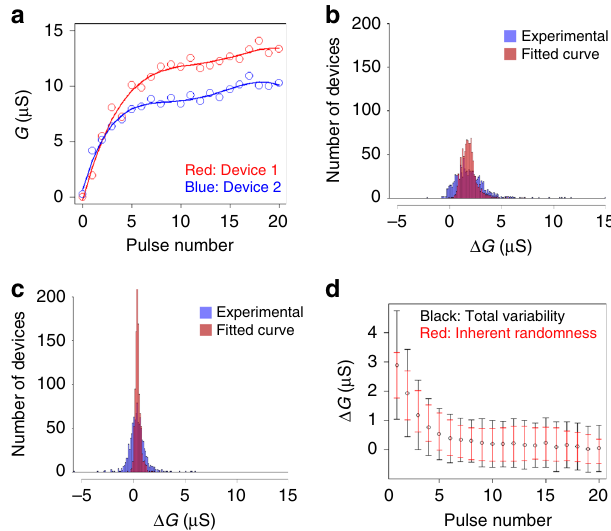
Fig. 5 Separation of device-to-device variability and inherent randomness for PCM. a Device G as a function of pulse number for two representative PCM devices (devices 1 and 2), fabricated with the identical process. The predicted noise-free signals from the GPR fi tting are shown in red and blue solid lines. The difference of two fi tted lines corresponds to device-to- device variability, whereas the fl uctuations of the experimental data around the fi tted lines are attributed to inherent randomness from individual devices. Histograms of Δ G values extracted from experimental data (blue) and fi tted curves (red) ( b ) after the second pulse and ( c ) after the sixth pulse. d The mean and standard deviation of Δ G obtained from the experimental data (shown in black circles and error bars) were compared with the root mean square of inherent randomness ( r ) obtained from the GPR-based methodology (shown in red error bars) as a function of pulse number. The inherent randomness accounts for 67% of the total